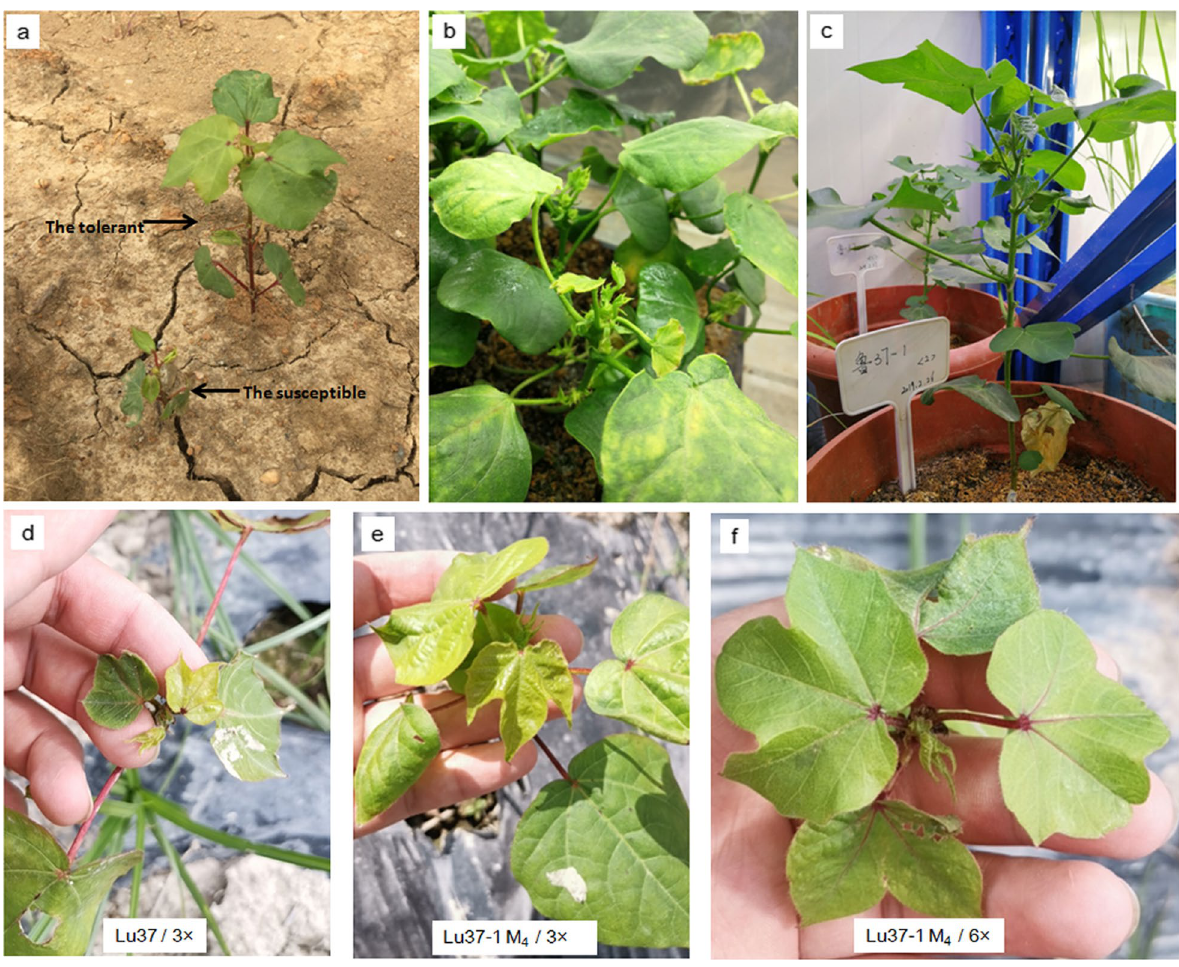
Fig. 1 Herbicide screening of the Lu37-1 cotton mutant with imazapic. a Field screening of the cotton M 2 generation by pre-emergent application of the 6 the recommended rate. b At 44 DAT, susceptible M 3 plantlets under imazapic treatment in the growth chamber. c At 70 DAT, two × imazapic-tolerant